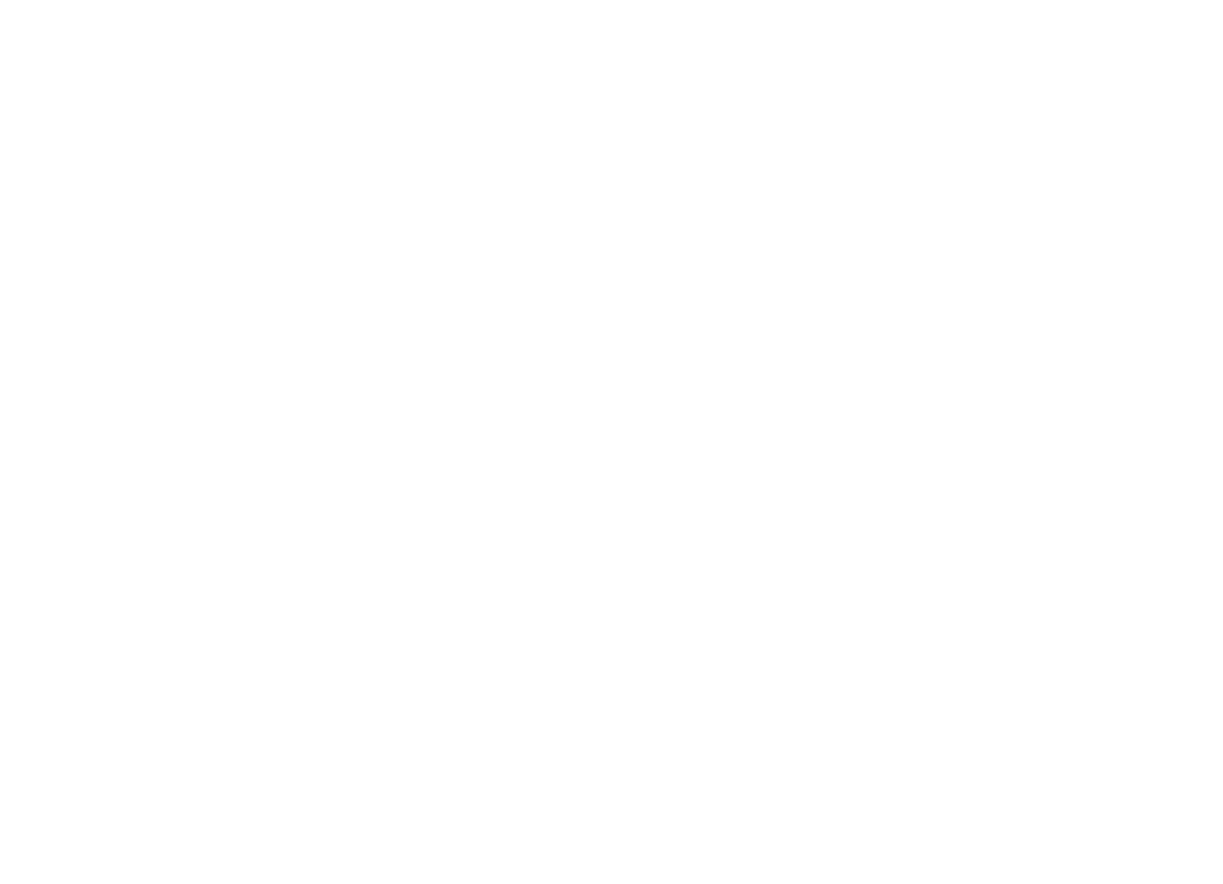
significant. Region 2: The rate of inner retinal loss was statistically significant. The rate of thinning went from 4.0 μ m/y to 1.1 μ m/y after FAc implant